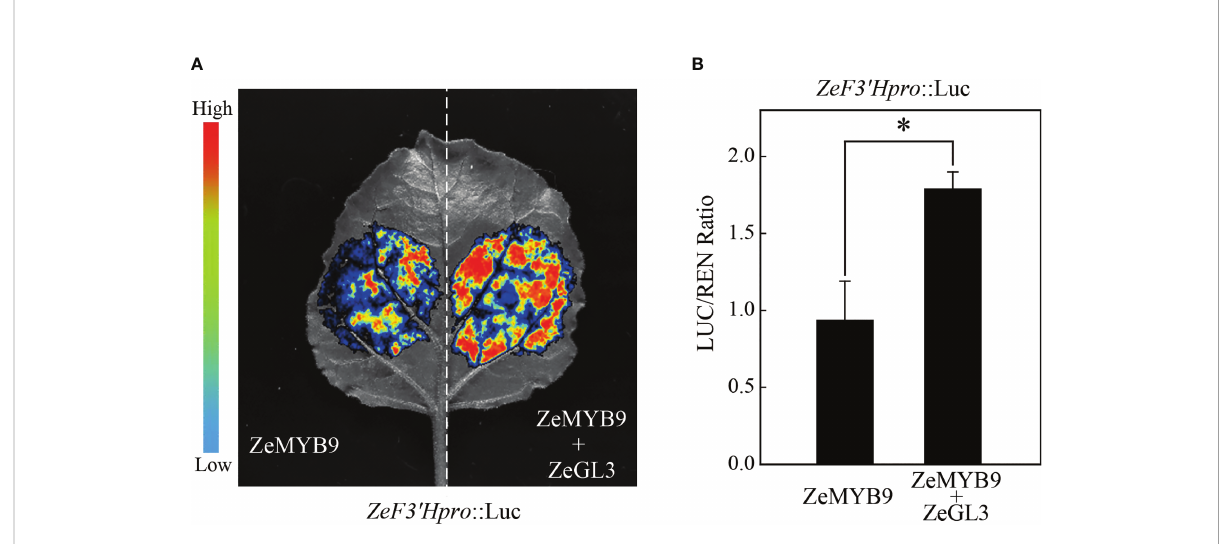
FIGURE 6 ZeMYB9 can form complexes with ZeGL3 to activate the expression of ZeF3 ’ H . (A) Dual-luciferase assay in N. benthamiana leaves. (B) Ratio of LUC to REN activity. The data were the mean ± SE from three biological replicates. T-test was used for statistical analyses compared with corresponding control (* P <